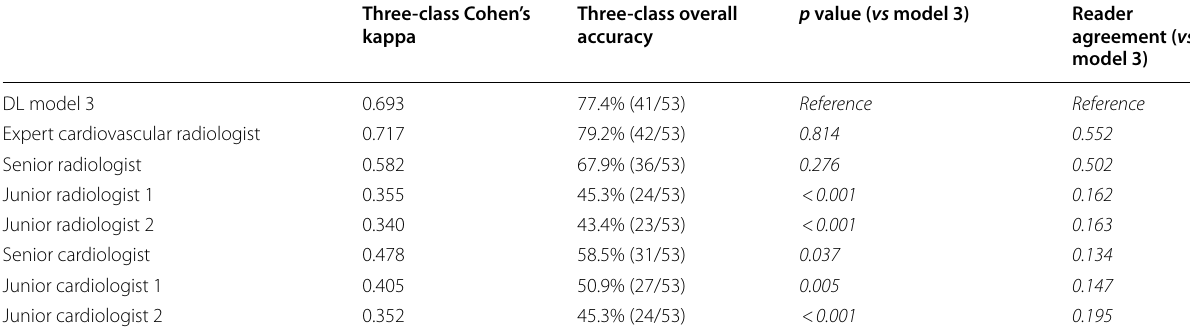
Table 2 Three‑class diagnostic performance of the Model 3 and radiologists/cardiologists in the external test dataset